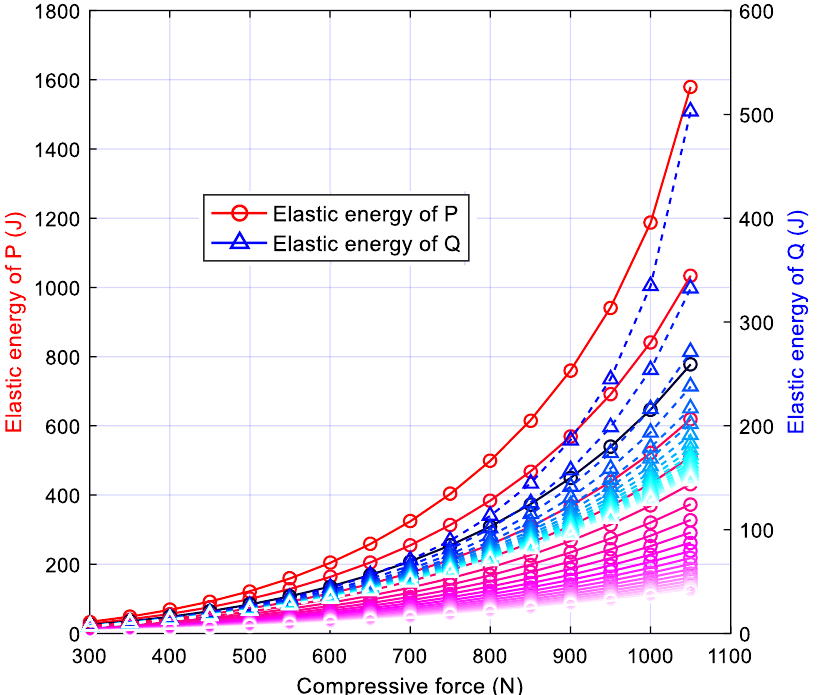
Figure 9. Energy storage of two leaf springs of the bionic leg under different compression forces and E P .